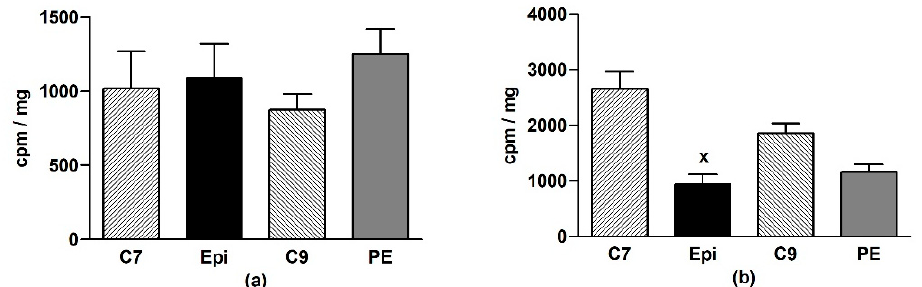
Figure 3. The e ff ect of (–)-epicatechin on the superoxide production in the left heart ventricle ( a ) and aorta ( b ) of borderline hypertensive rats. The values represent the mean ± SEM. x p < 0.001 vs. C7 group, n = 6–7 per group. Abbreviations. C7: seven-week-old control group, C9: nine-week-old control group, Epi: (–)-epicatechin group, PE: (–)-epicatechin post-treatment group.